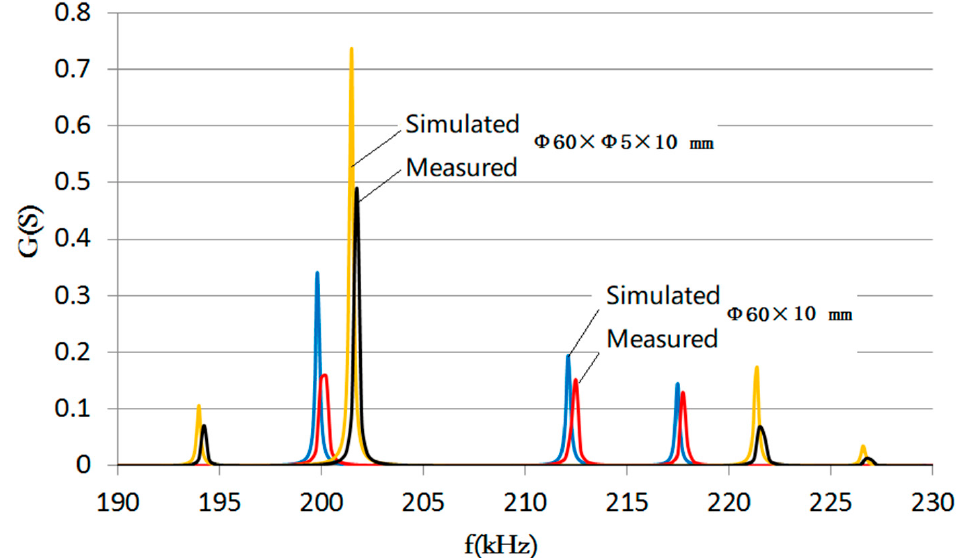
Figure 5. Conductivity curve of piezoelectric disc with a hole in the center. The piezoelectric disc with a hole in the center can also improve the sound energy radiated by the disc transducer and optimize the thickness vibration mode. Figure 6 simulates and calculates the vibration mode at the thickness vibration frequency of the circular plate with a hole. It can be seen from the figure that the amplitude of the vibrator surface is relatively more uniform than that of the central nonporous piezoelectric circular plate, and the amplitude fluctuation is